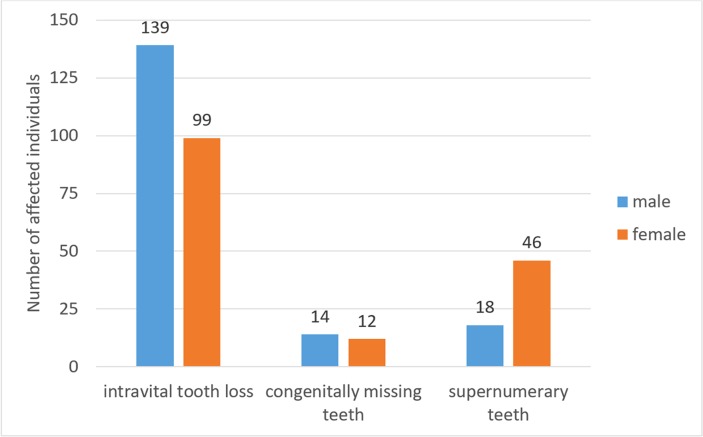
Numbers of Eastern Atlantic harbor seals (Phoca vitulina vitulina) in the study sample exhibiting numerical dental anomalies.The criteria for classifying cases of missing teeth are given in the text.